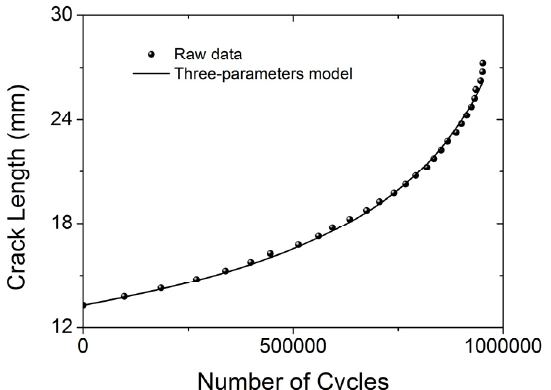
Figure 10: Raw crack growth data and three-parameters fitting function.